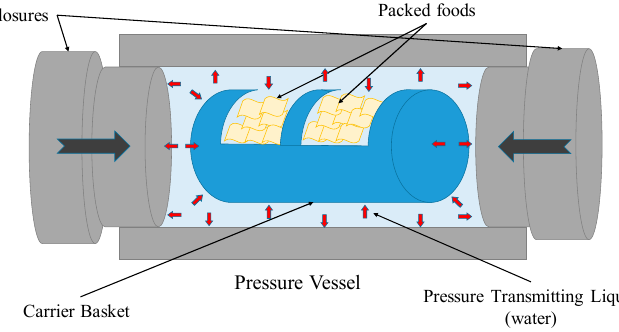
Figure 1. Schematic representation of a high pressure processing (HPP) vessel.